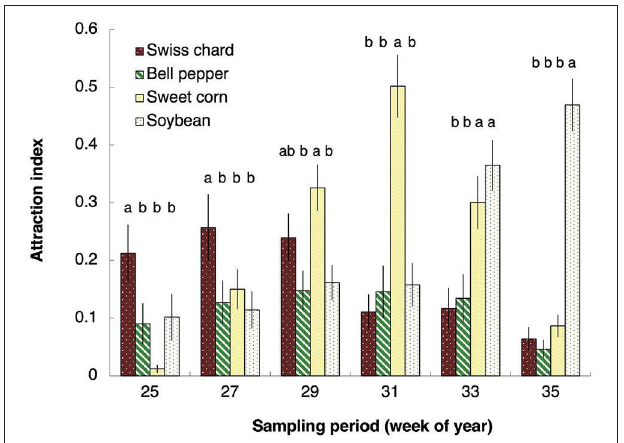
FIGURE 2 | Comparison of Halyomorpha halys nymph attraction to four host plants over a series of six sampling periods (combined 2013 + 2014 data). Bars with the same letter are not significantly different (Tukey’s HSD, P < 0.05).